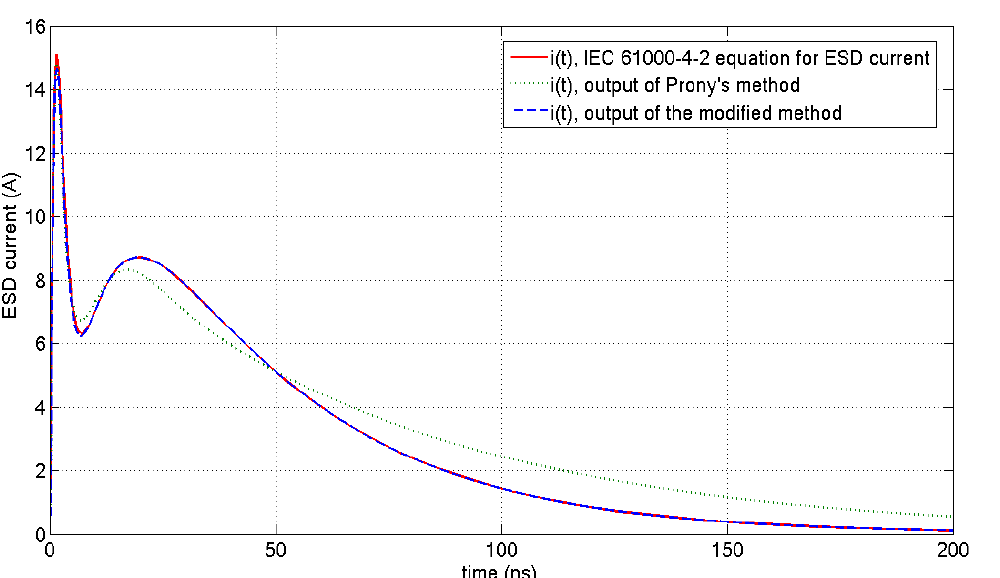
Figure 4. Plot of the IEC 61000-4-2 equation for the ESD current at 4 kV, together with the outcome of the standard and modified Prony Method.